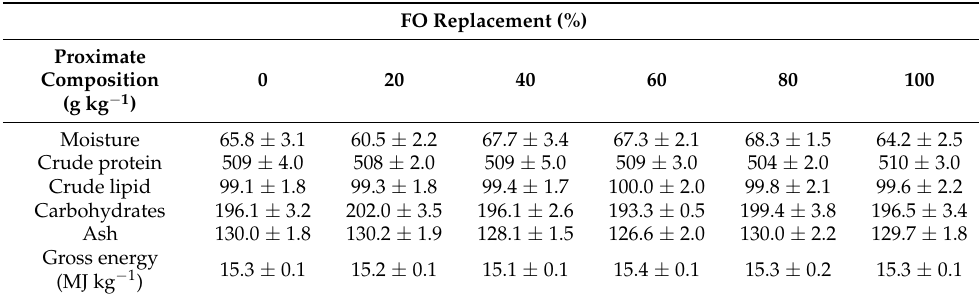
Table 2. Proximate composition (g kg − 1 diet, wet basis) of the practical diets with different replace- ments of cod liver oil (FO) with camelina oil